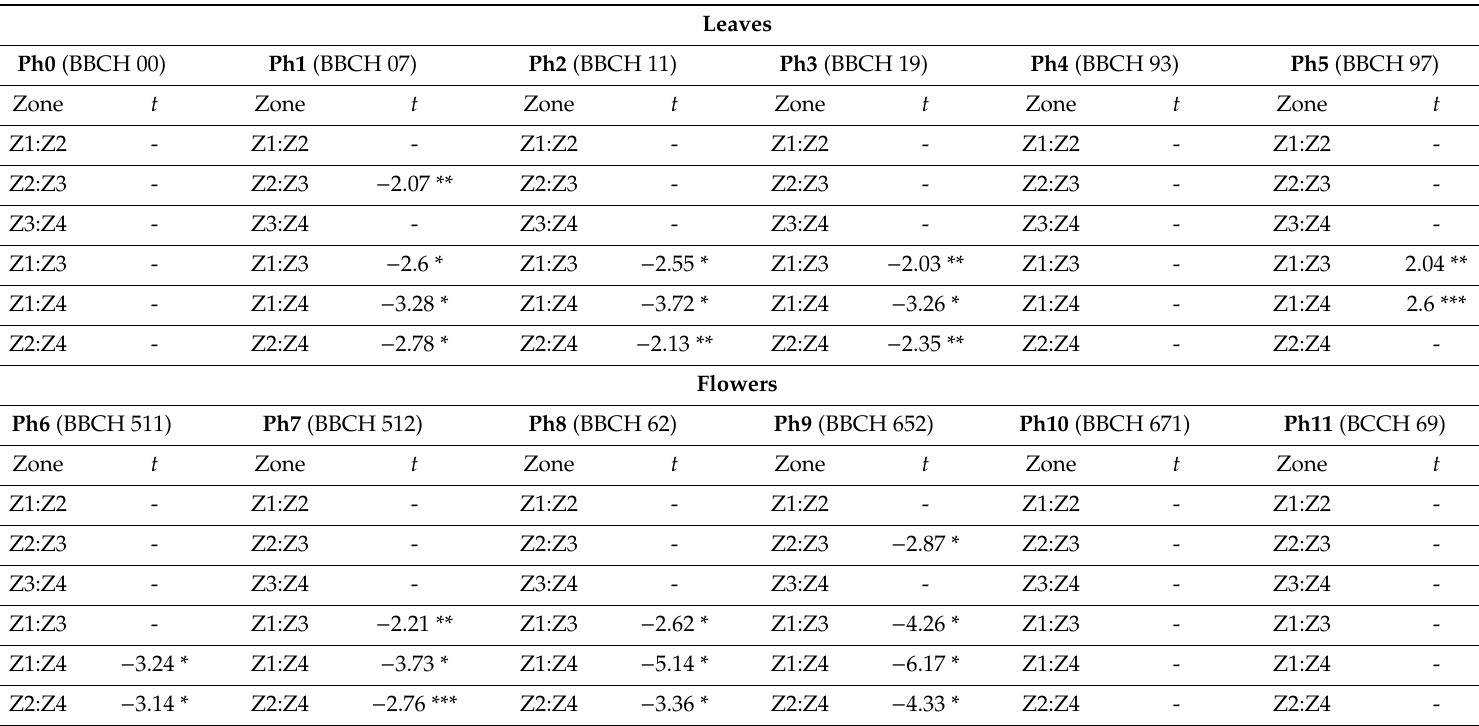
Table 5. The values of Student’s t -test for phenological phases (Ph) of leaves and flowers between trees, growing in individual zones (Z1–Z4) of the city.